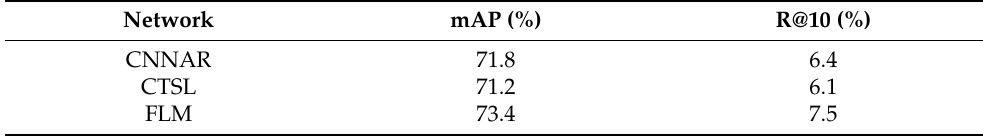
Table 4. Retrieval accuracy of different models in Paris500K.